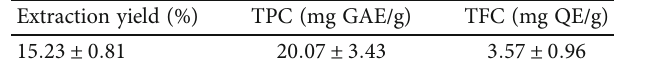
Table 1: Extraction yield, total phenolic content (TPC), and fl avonoid content (TFC) of Mao fruit juice. Extraction yield